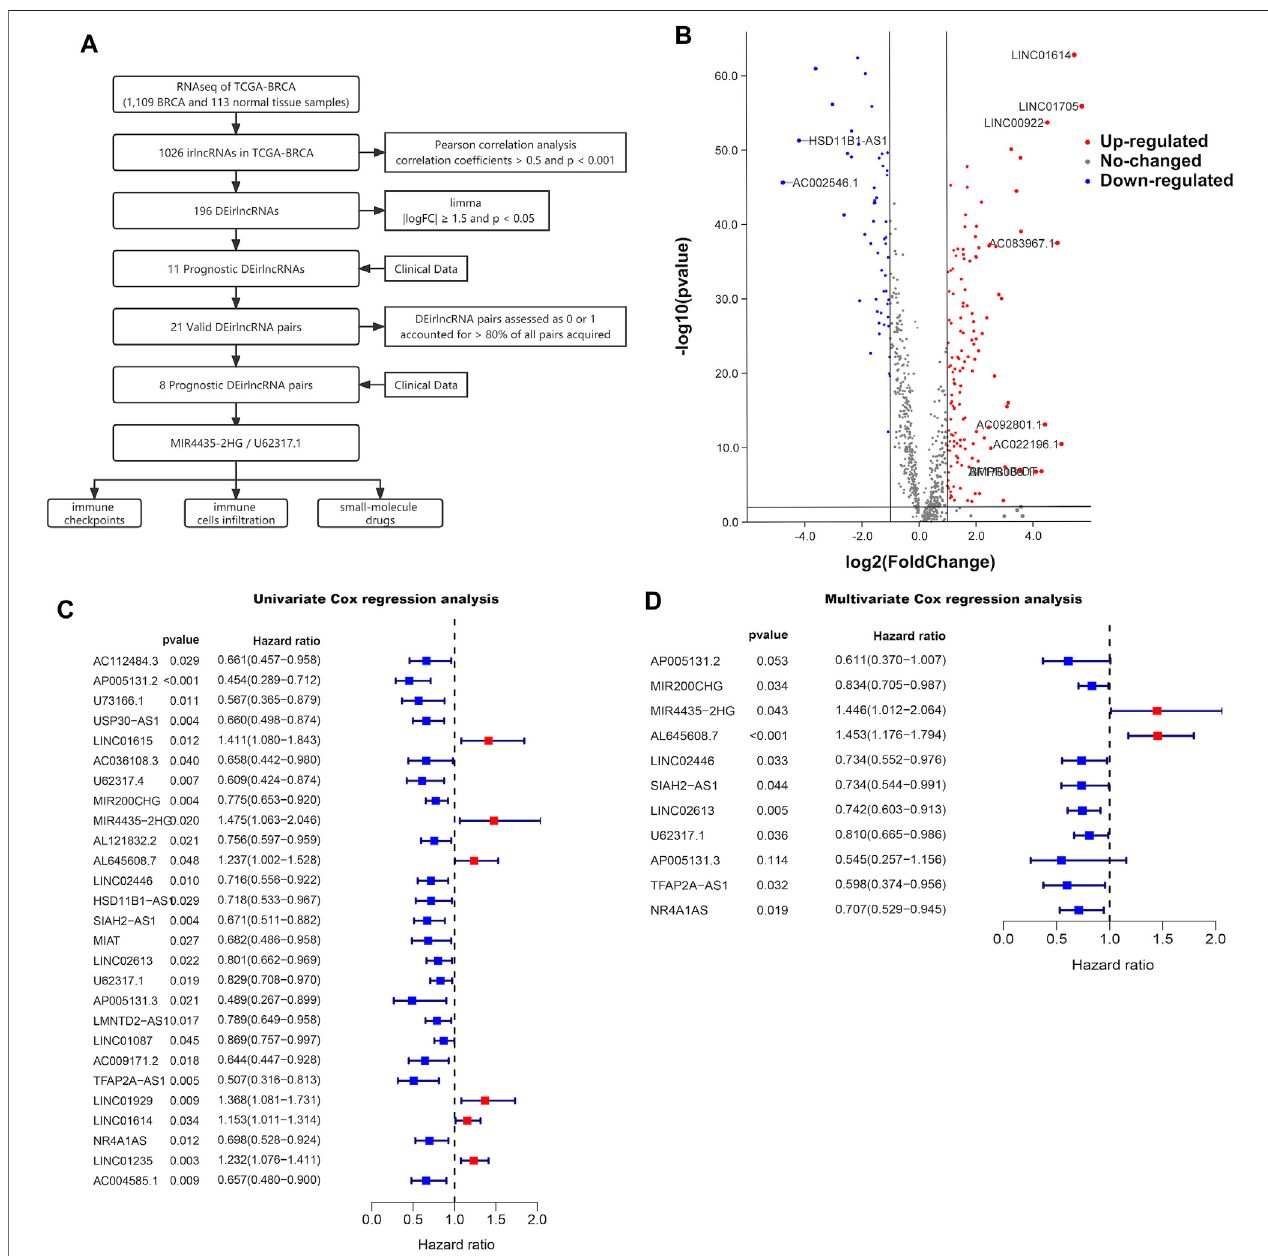
FIGURE 1 | Prognostic value in BRCA. (A) Work fl ow of this study. (B) Volcano plot of differentially expressed irlncRNAs between 113 normal and 1,109 tumor tissuesamplesintheTCGA-BRCAcohort.ForestplotsdisplaythedifferentialexpressionofirlncRNAsassociatedwithOS.HRand95%CIwerecalculatedbyunivariate (C) and multivariate (D) cox regression